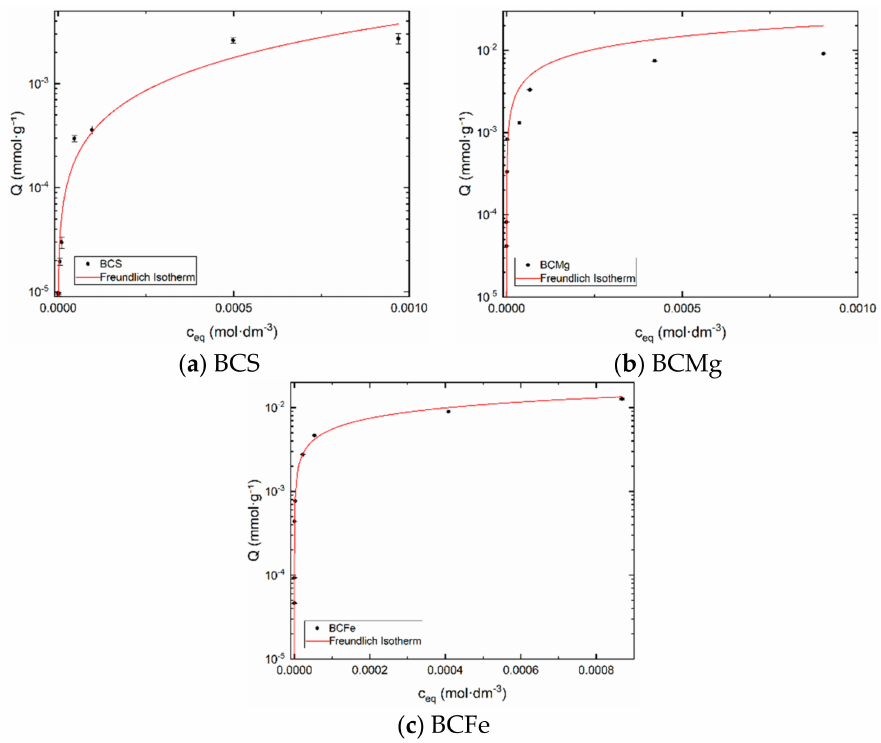
Figure 4. Freundlich isotherms. ( a ) BCS, ( b ) BCMg, ( c ) BCFe. Freundlich constants k F , regression constants n F , and coefficients of determination R 2